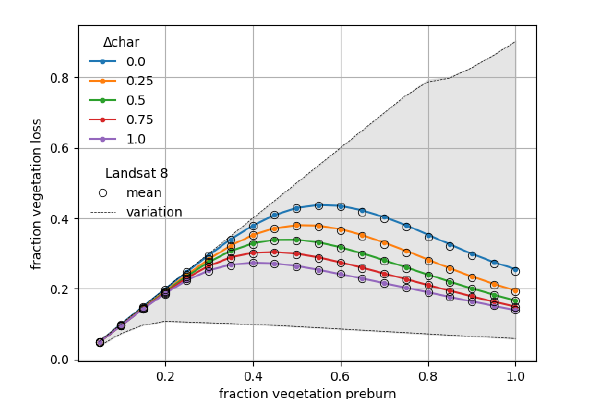
Figure A11. Vegetation loss results depending on starting vegetation fraction and ∆ char parameter setting, park-wide for Sentinel-2B, dNBR threshold = 0.15. Mean values are shown in colored lines, with total model result variation shown in gray. To compare, the results for Landsat 8 are shown in black, with mean values shown by circles and total model result variation shown by dashed lines.